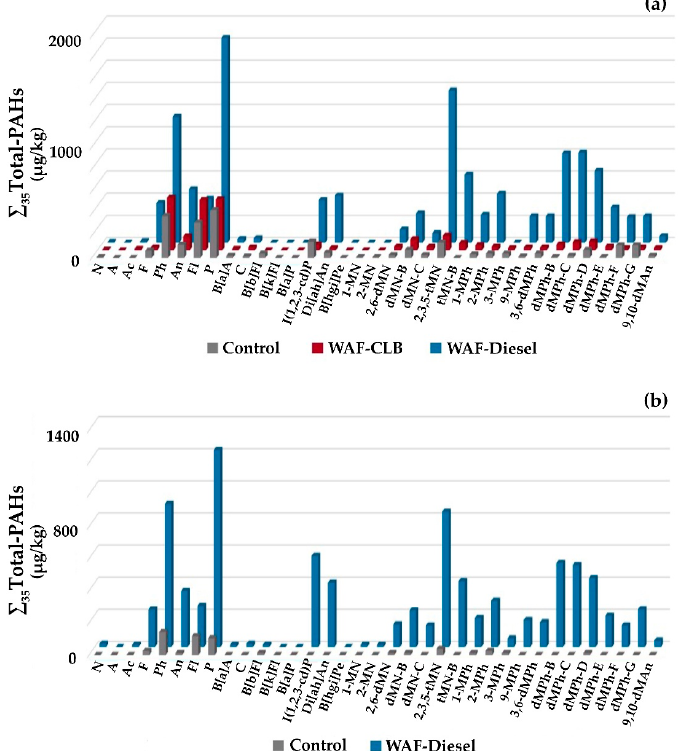
Figure 12. ∑ 35 Total-PAHs (µg/kg) measured in ( a ) hepatopancreas and ( b ) eggs of lobsters under each treatment (Control, WAF-CLB, and WAF-Diesel). ∑ 16 PAHs-EPA: N: Naphthalene; A: (Control, WAF-CLB, and WAF-Diesel). ∑ 16 PAHs-EPA: N: Naphthalene; A: Acenaphthylene; Ac: Acenaphthene; F: Acenaphthylene; Ac: Acenaphthene; F: Fluorene; Ph: Phenanthrene; An: Anthracene; Fl: Fluoran- thene; P: Pyrene; B[a]A: Benzo[a]anthracene; C: Chrysene; B[b]Fl: Benzo[b]fluoranthene; B[k]Fl: Fluorene; Ph: Phenanthrene; An: Anthracene; Fl: Fluoranthene; P: Pyrene; B[a]A: Benzo[a]anthracene; C: